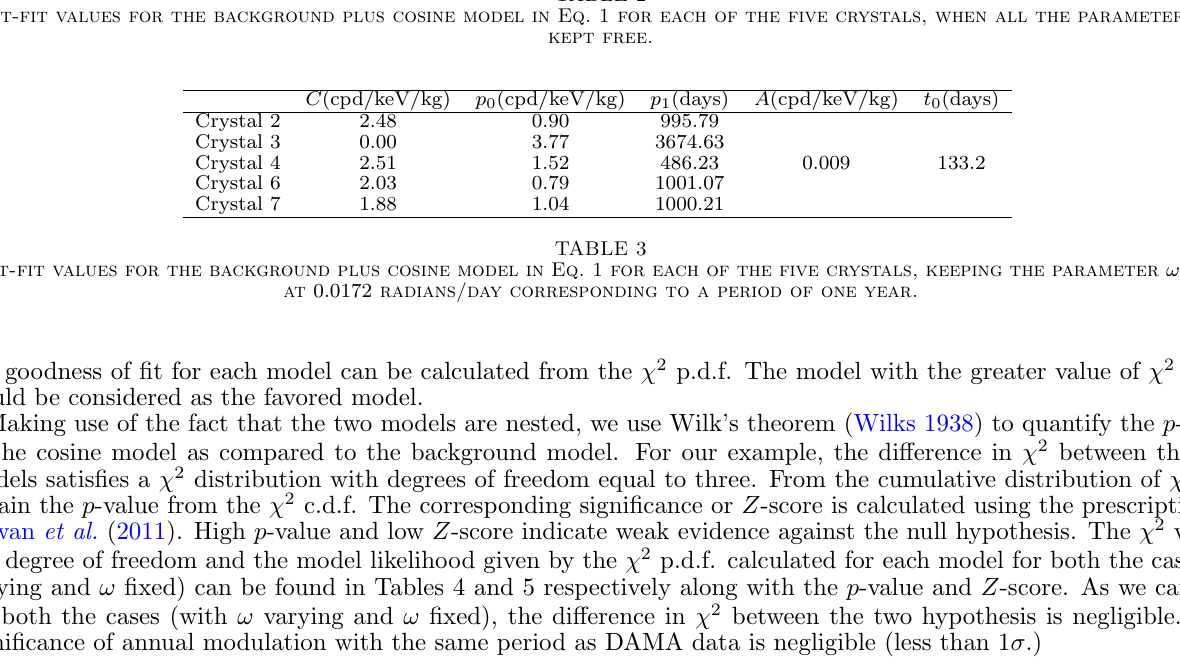
Best-fit values for the background plus cosine model in Eq. 1 for each of the five crystals, when all the parameters are